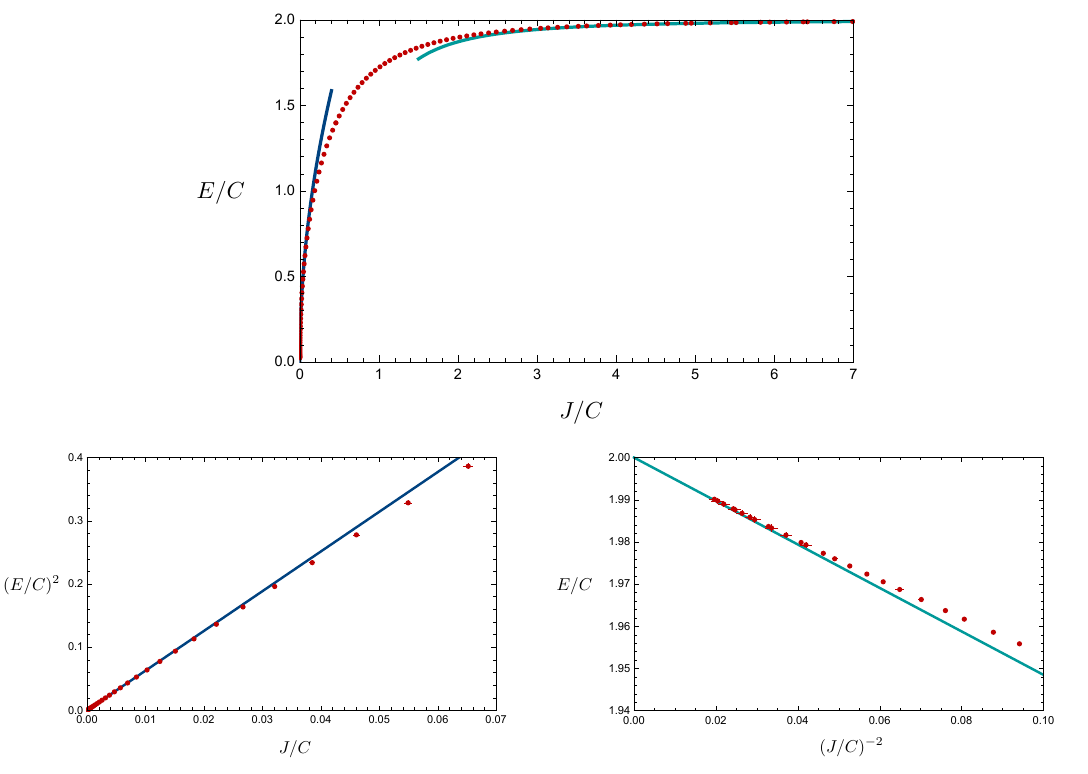
Figure 4 . Numerical computation of the spectrum of the rotating string, for fixed values of ω (red points), for log ω ranging from − 6 to 4 . 9 in increments of 0 . 1 (top figure). We write E and J in units of C = R 2 / 2 πα 0 . The asymptotic low- and high-energy analytic expressions of eqs. (3.7) and (3.8) are plotted in blue and teal, respectively. In the second row is a numerical check, with error bars plotted, of the approach to the asymptotic forms for (left) low (3.7) and (right) high (3.8)